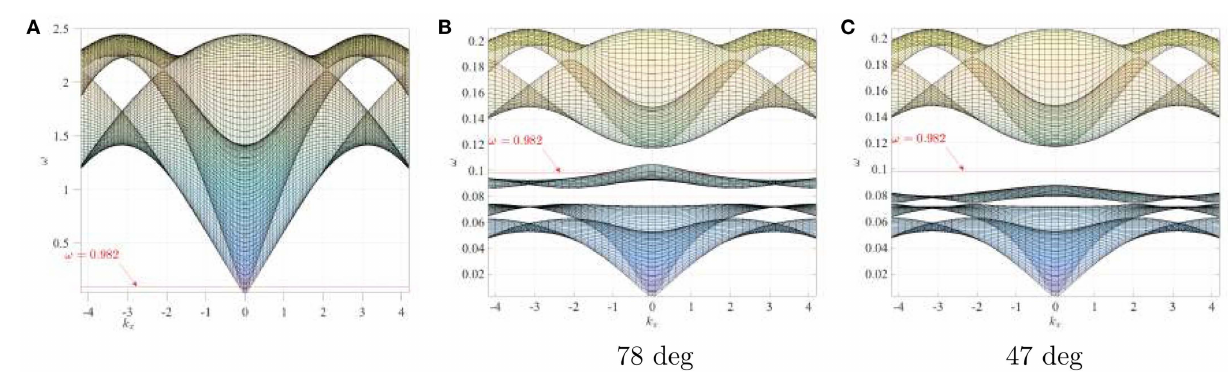
Frontiers in Materials |